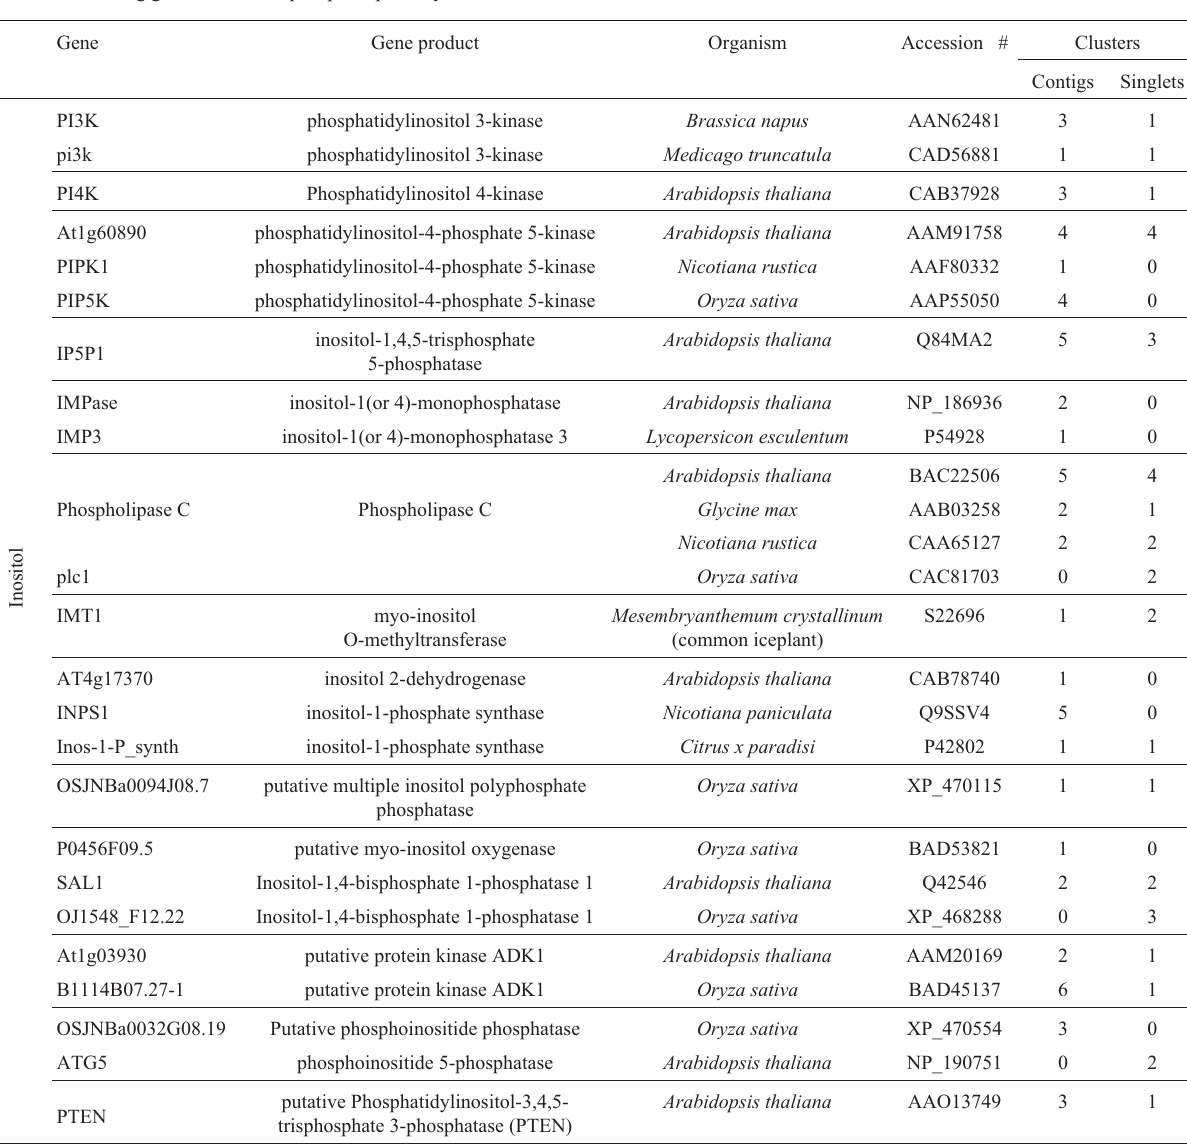
Table 9 - Ortholog genes of Inositol phosphate pathways found in the Citrus EST database.